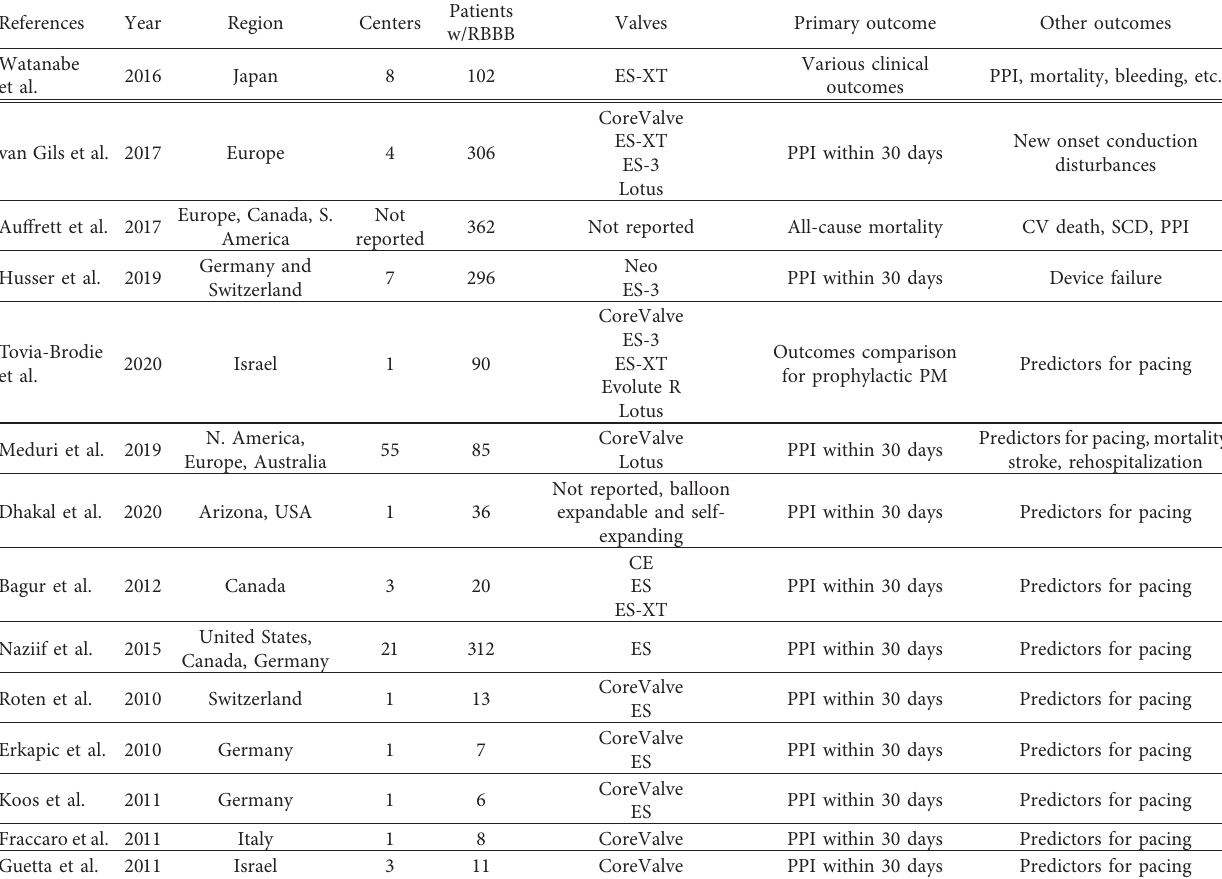
Table 2: Outcomes of patients with preexisting RBBB after TAVR summary